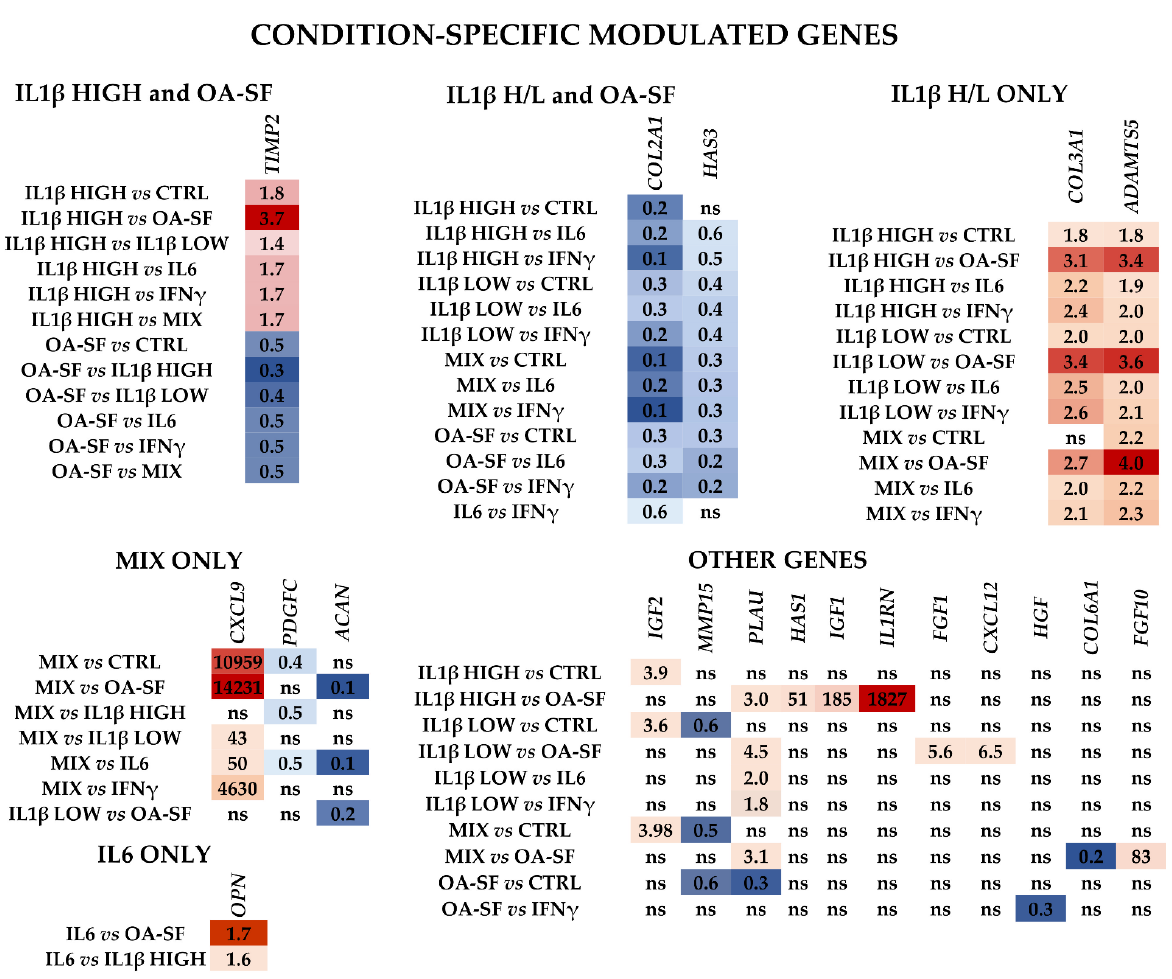
Figure 6. Differential expression of other single or multiple condition specific genes with respect to control (CTRL) and the other stress treatments (abbreviations as in Figure 2) in the three HCH donors. Red shades indicate higher expression ratios and blue shades indicate lower expression ratios of each group/condition with respect to the other conditions. Color key indicates the intensity associated with expression ratios. Mean values are shown. ns = not statistically significant (p-value > 0.05). p-value for each shown ratio can be found in Supplementary Table S4.